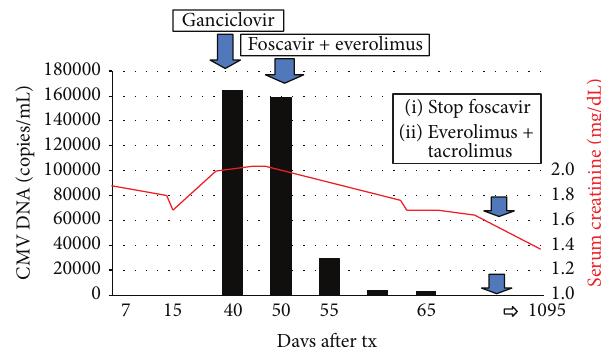
Figure 1: Laboratory trend of serum creatinine levels (line) and CMV DNA on plasma (bars) over time and therapy